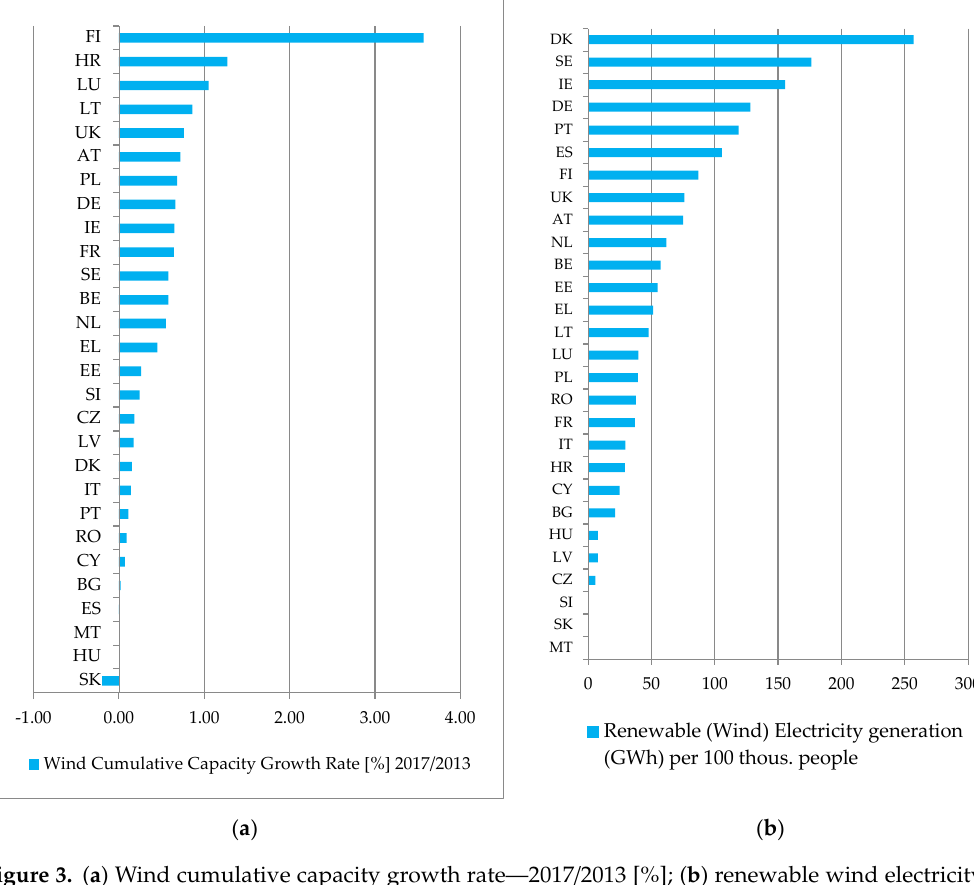
Figure 3. ( a ) Wind cumulative capacity growth rate—2017/2013 [%]; ( b ) renewable wind electricity generation (GWh) per 100 thous. people.